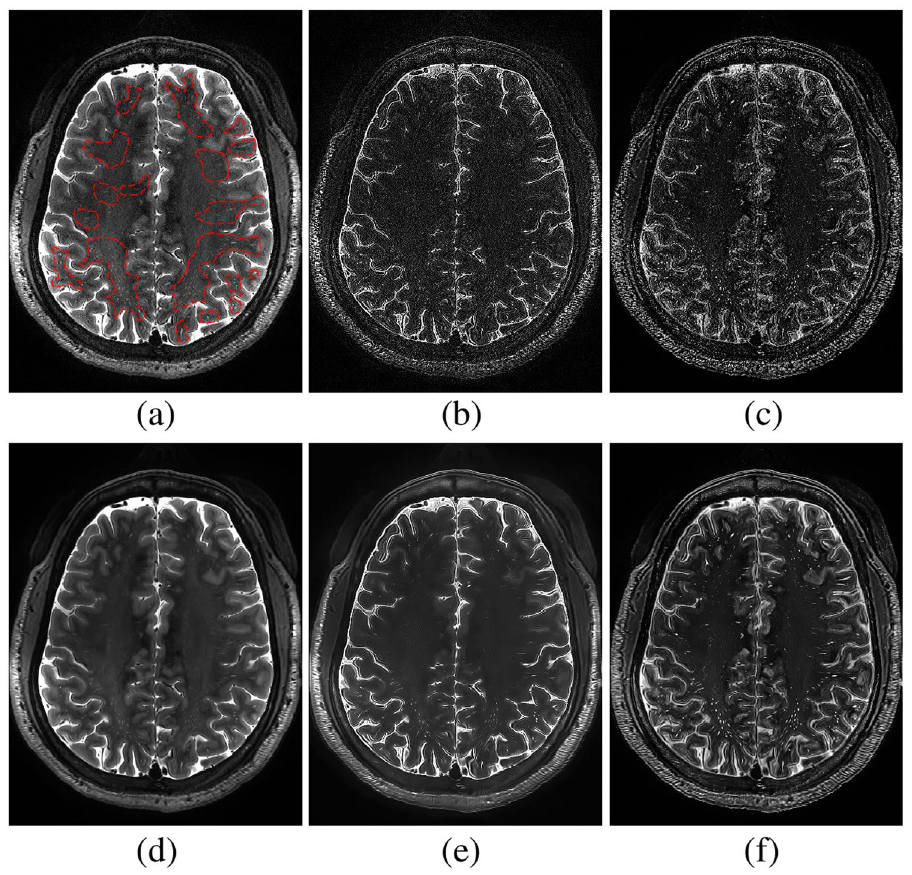
Figure 1. ( a ) Illustration of PVSs in a 7 T MR image. Those relatively bright voxels within the red dotted contours are the PVSs. ( b ) Enhanced image by using spatial correlation filtering; and ( c ) enhanced image by using our proposed method. ( d – f ) Show the denoised images of ( a – c ), respectively. For these three cases, the BM4D method uses the same parameters to denoise the